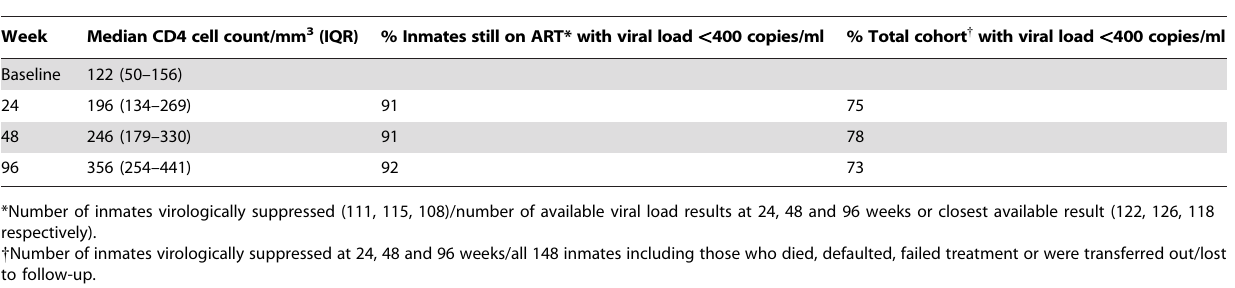
Table 1. Virological and immunological outcomes at 24, 48 and 96 weeks.